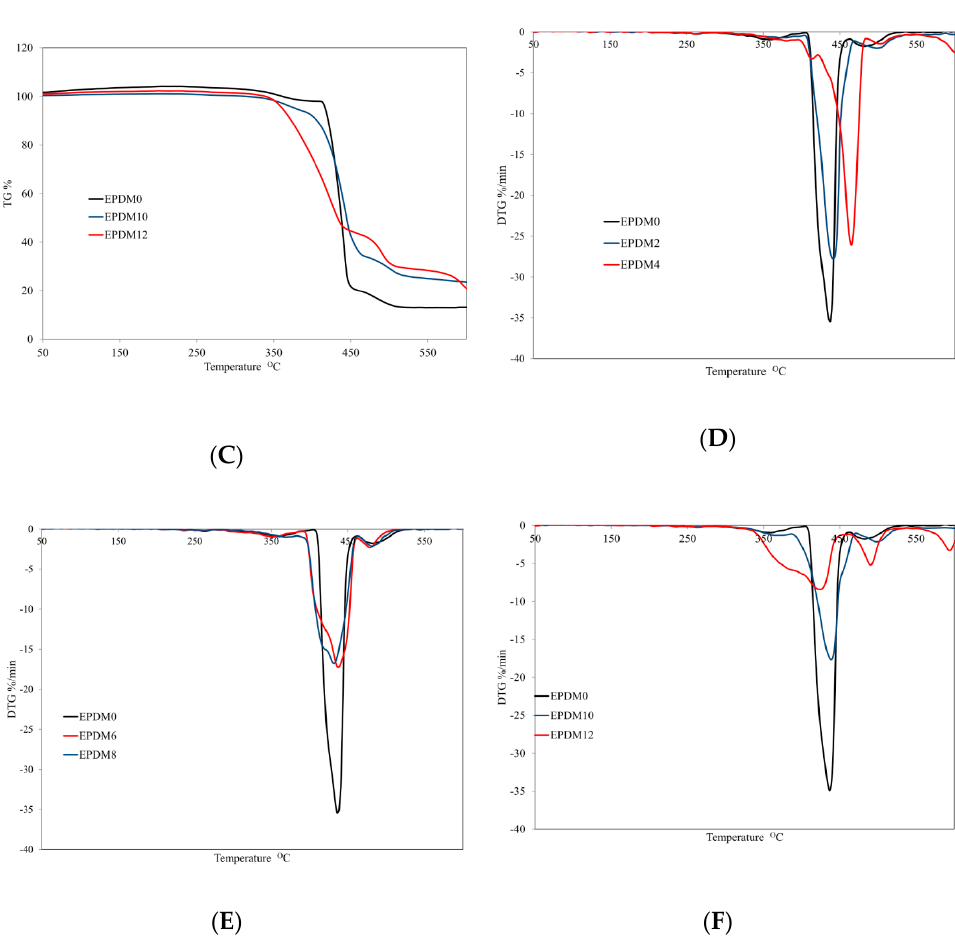
Figure 3. Thermogravimetric analysis data obtained for EPDM-filled composites: ( A – C ) TG curves and ( D – F ) DTG curves.